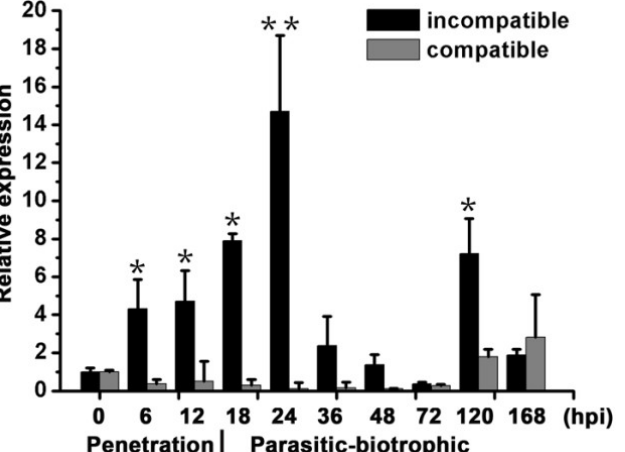
Figure 1. Expression profile of TaBIR1 during wheat- Pst interaction. The second leaves of wheat cultivar Suwon11 were inoculated with fresh urediospores of avirulent Pst race CYR23 (incompatible interaction) or virulent Pst race CYR31 (compatible interaction) and sampled at different hours post-inoculation (hpi) for RNA extraction. Relative transcript levels of TaBIR1 were calculated by the comparative threshold (2 −ΔΔCT ) method and normalized to the transcript level of TaEF . Values represent the means ± standard errors of three independent biological replicates. Asterisks indicate significant differences (* p < 0.05, ** p < 0.01) comparing to TaBIR1 expression level at 0 hpi using Student’s t -tests.